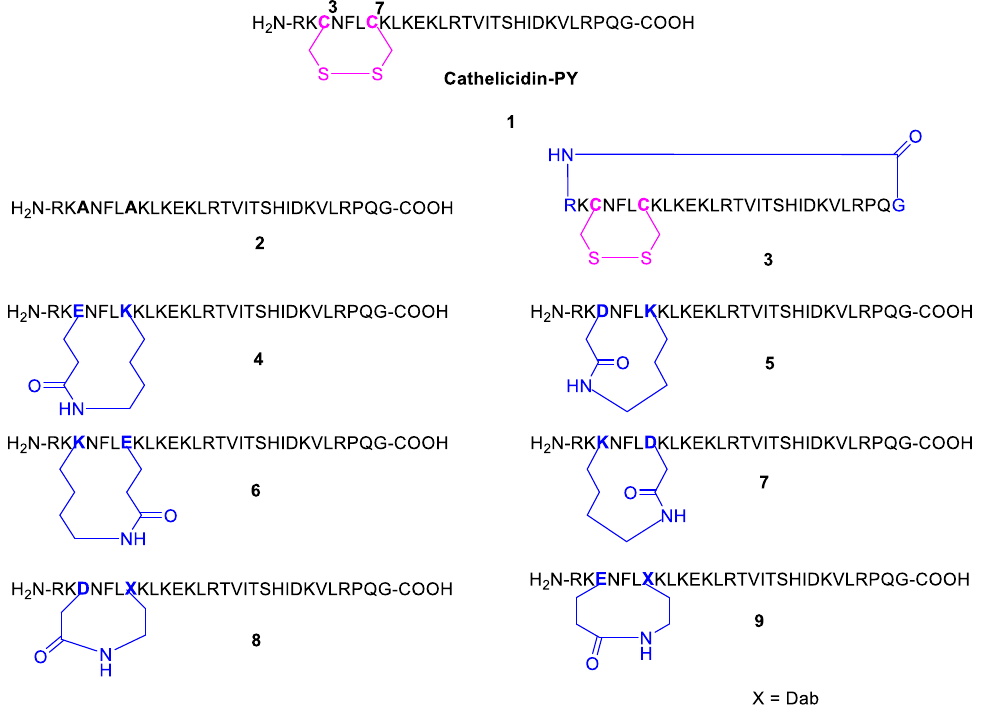
Figure 2. Structure of the cathelicidin-PY peptide, 1 , and a series of analogues, 2 – 9 of cathelicidin-PY. Dab = 2,4-diaminobutyric acid.